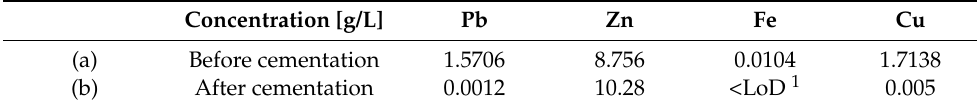
Table 3. Chemical analysis of solution (a) before and (b) after cementation.